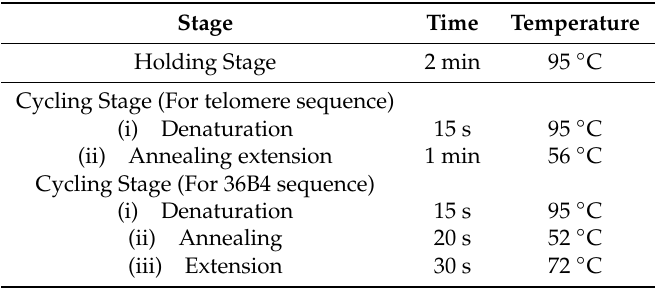
Table 4. Cycling condition for telomere length